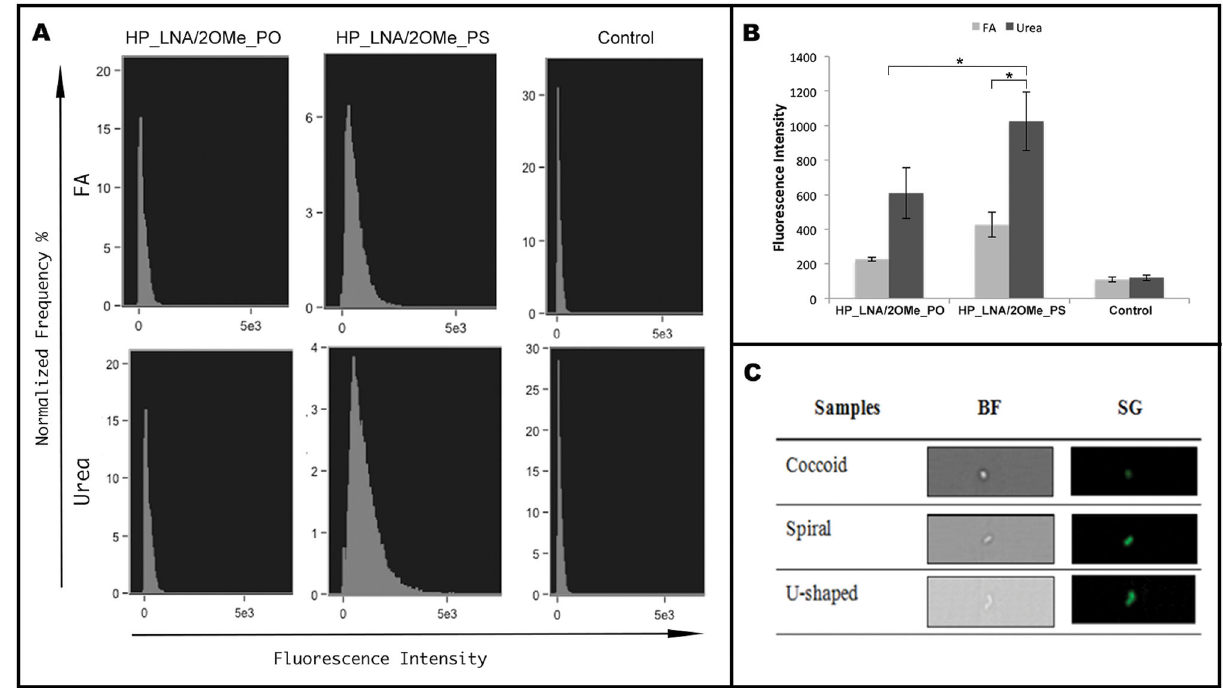
Figure 3. FISH detection of H.pylori by imaging flow cytometry. FAM labeled 2OMe/LNA probes were analysed in 50% (v/v) formamide buffer and in 4M buffer. A) Representative histograms of the green fluorescence intensity of FAM-labeled HP_LNA/ 2OMe_PO, HP_LNA/2OMe_PS probes and controls. B) Quantification of the mean fluorescence intensity of each probe in two independent experiments obtained by flow cytometry. C) Representative images of individual H. pylori with different morphologies. The population identified as individual H. pylori bacterium by FISH analysis was manually examined and individual cell events were identified. Individual bacterial cells, shown by Brightfield images (BF, left column) and green fluorescence images (SG, right